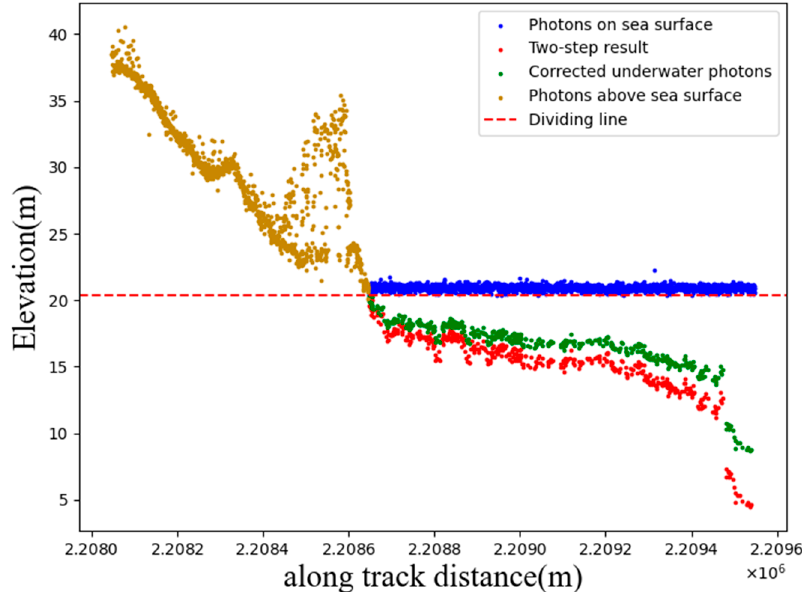
Figure 10. Correction of gt1r beam refraction for orbit 480.